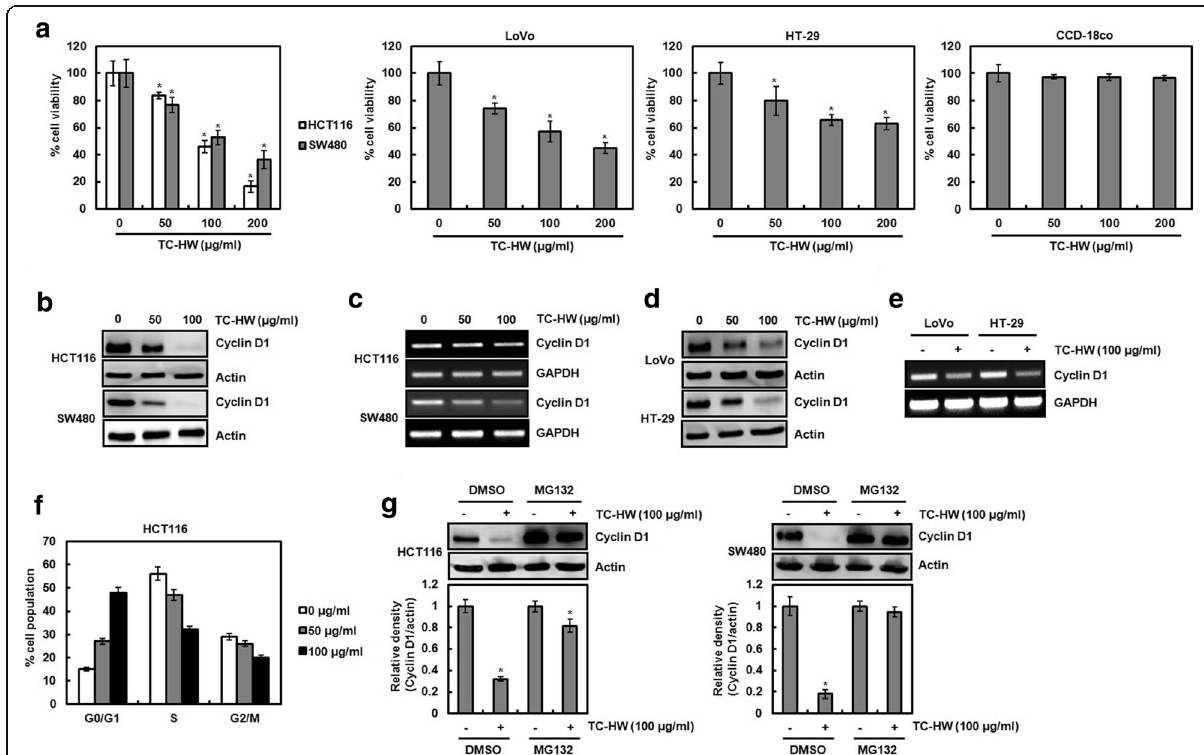
Fig. 1 The effect of TC-HW on the cell viability and cyclin D1 expression in human colorectal cancer cells. a HCT116, SW480, LoVo and HT-29 cells were plated overnight and then treated with TC-HW at the indicated concentrations for 24 h. Cell viability was measured using MTT assay. * P <0.05 compared to cell without TC-HW. b-e HCT116, SW480, LoVo and HT-29 cells were plated overnight and then treated with TC-HW at the indicated concentrations for 24 h. For Western blot analysis ( b , d ), cell lysates were subjected to SDS-PAGE and the Western blot was performed using antibody against cyclin D1. Actin was used as internal control for Western blot analysis. For RT-PCR analysis of the gene expression of cyclin D1 ( c , e ), total RNA was prepared. GAPDH was used as internal control for RP-PCR. f HCT116 cells were plated overnight and then treated with TC-HW at the indicated concentrations for 24 h. Cell cycle progression was analyzed by flow cytometer. g HCT116 and SW480 cells were pretreated with MG132 (10 μ M), and then co-treated with TC-HW (100 μ g/ml). Cell lysates were subjected to SDS-PAGE and the Western blot was performed using antibody against cyclin D1. Actin was used as internal control for Western blot analysis. * P <0.05 compared to cell without